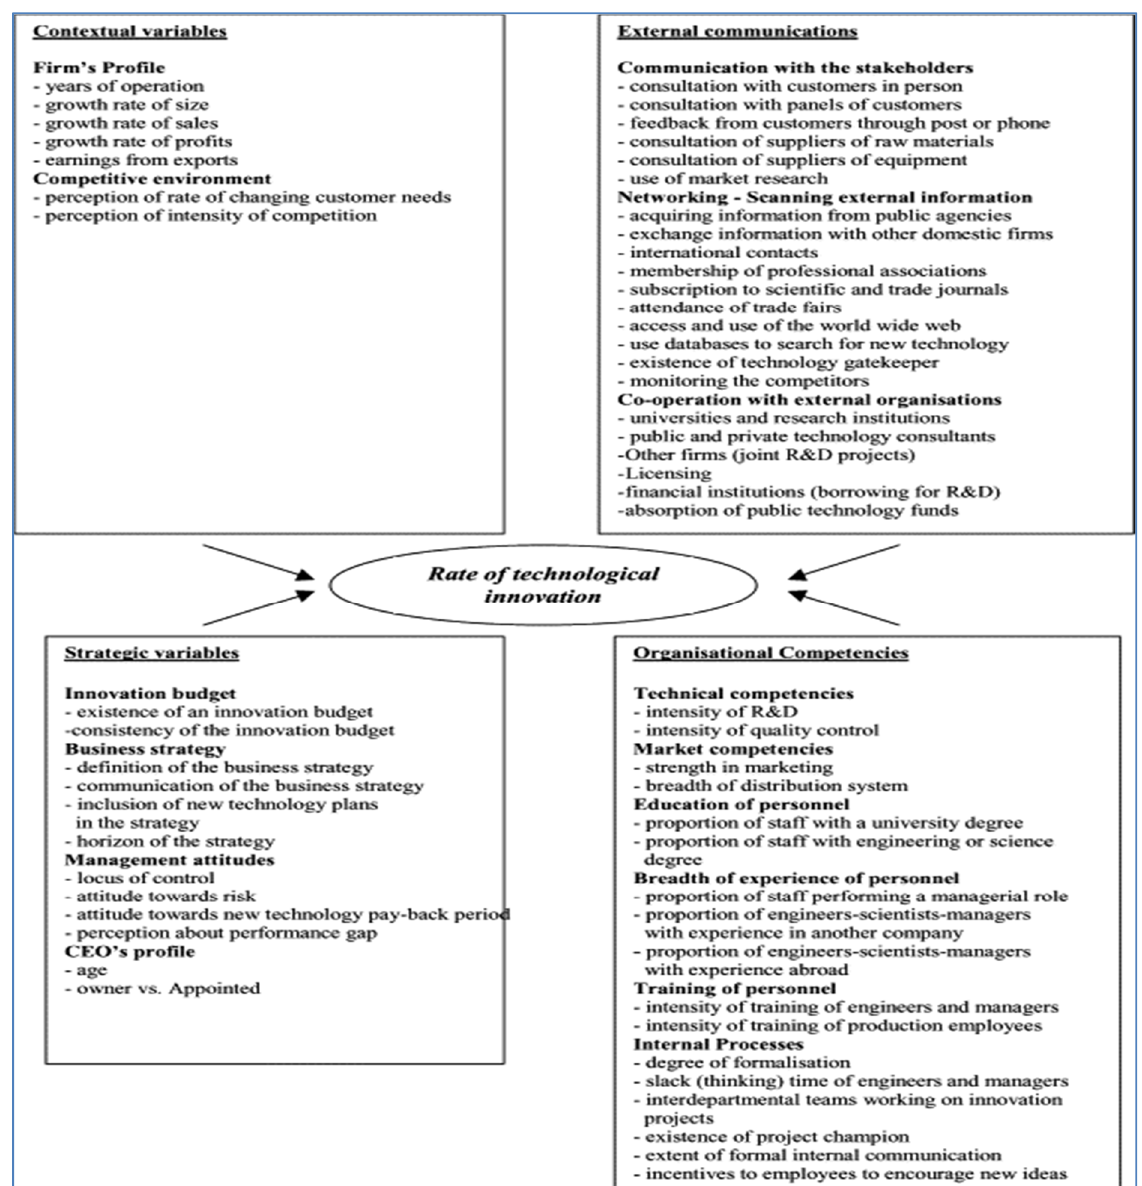
Table 4: The Portfolio Model Of Determinants Of